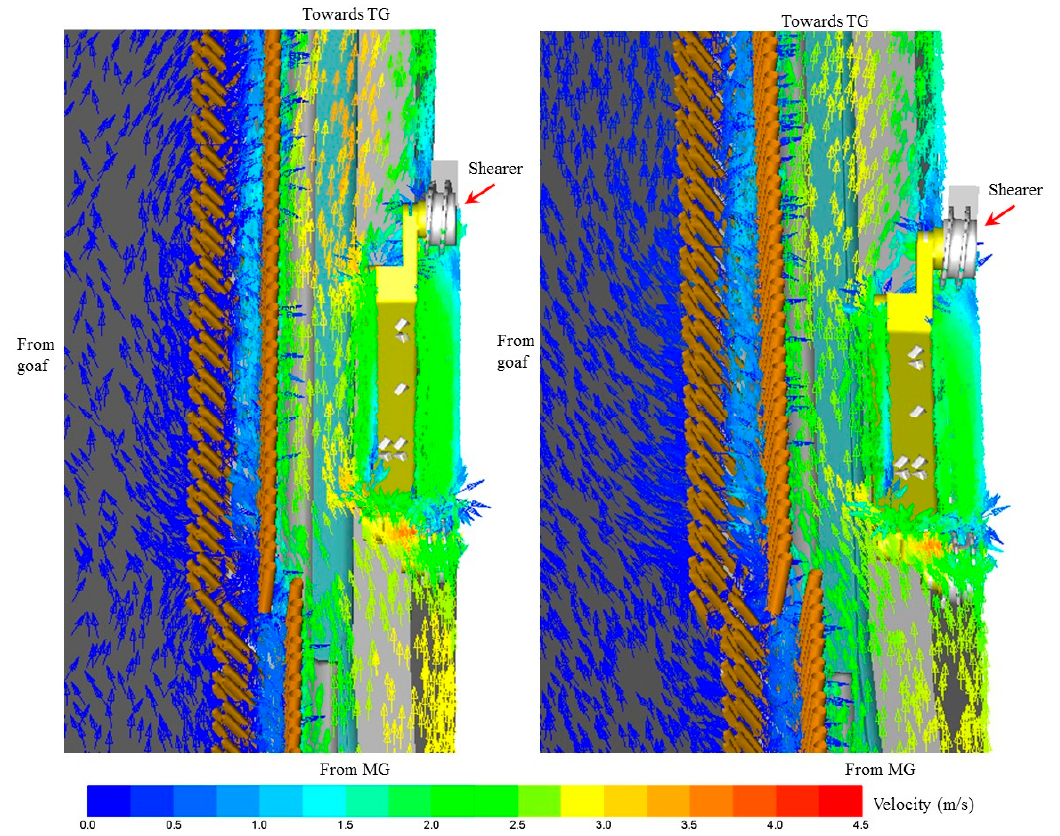
Figure 10. 3D view of velocity vectors around the shearer ( Left : MG-TG Case 2; Right : MG-TG Case 3).